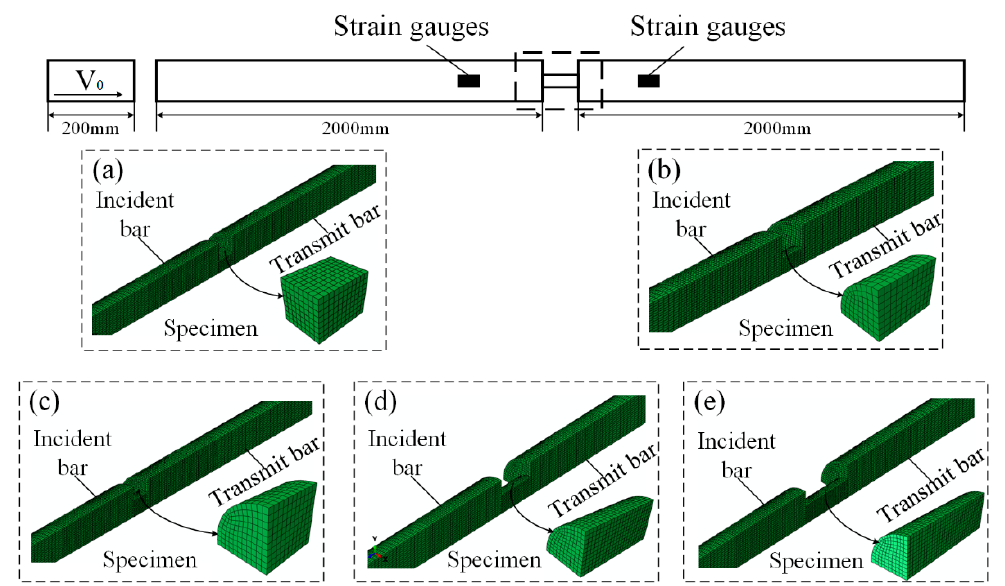
Figure 3. FEA model of a specimen with ( a ) cubic specimen with slenderness 0.66; ( b ) cylinder specimen with slenderness 0.66; ( c ) cylinder specimen with slenderness 0.5; ( d ) cylinder specimen with slenderness 1; ( e ) cylinder specimen with slenderness 1.5.